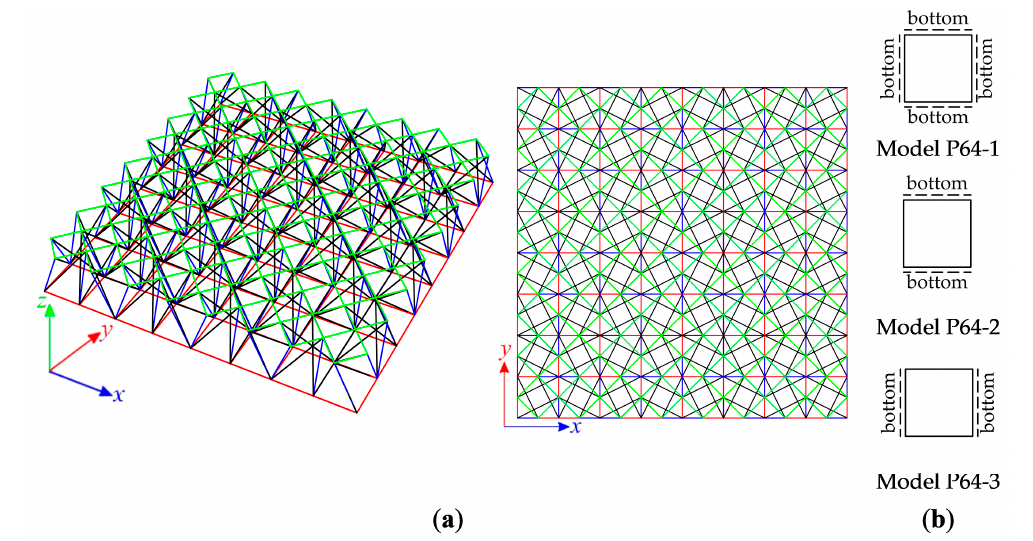
Figure 11. Sixty-four-module tensegrity plate-like structure: ( a ) geometry, ( b ) models.